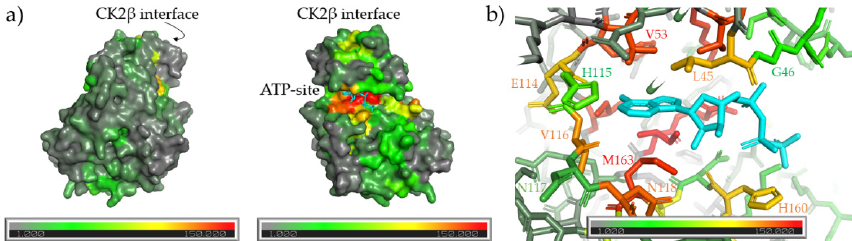
Figure 3. Heat map showing where known ligands bind to CK2 α . 180 crystal structures of CK2 α with ligands (excluding nucleotides binding to the ATP site) were analysed and interactions of the ligands with the kinase mapped. ( a ) Surface of CK2 α (PDB: 5CU6) is coloured based on the number of ligands that are found within 4 Å of any atom in the underlying residue. Darkest red shows residues that contact ligands in 150 structures while grey residues make no direct ligand interactions, with green and yellow representing intermediate values. In ( b ) ADP molecule is shown as light blue sticks for reference. Residues with atoms which are frequently found within 4 Å of a ligand are shown in green, yellow, orange and red reflecting the number of structures in which this proximity was identified; key binding residues also frequently identified as being in close proximity to inhibitors ligands have been labelled.